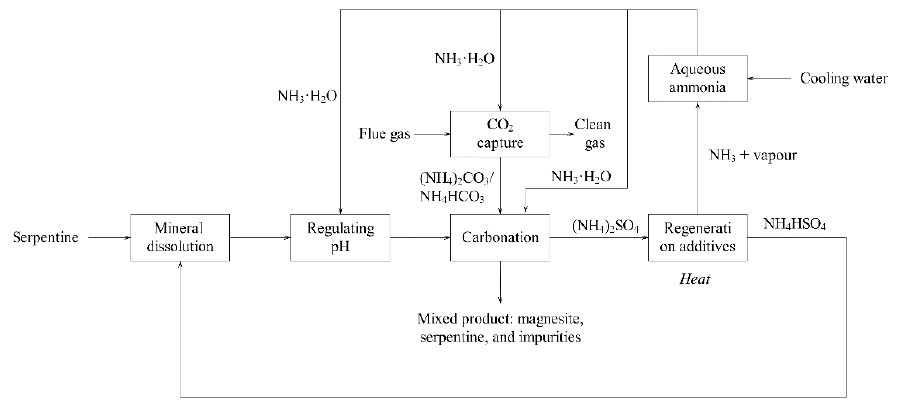
Figure 13. The schematic of carbon mineralization process using recyclable ammonium salts (modified from [183]).